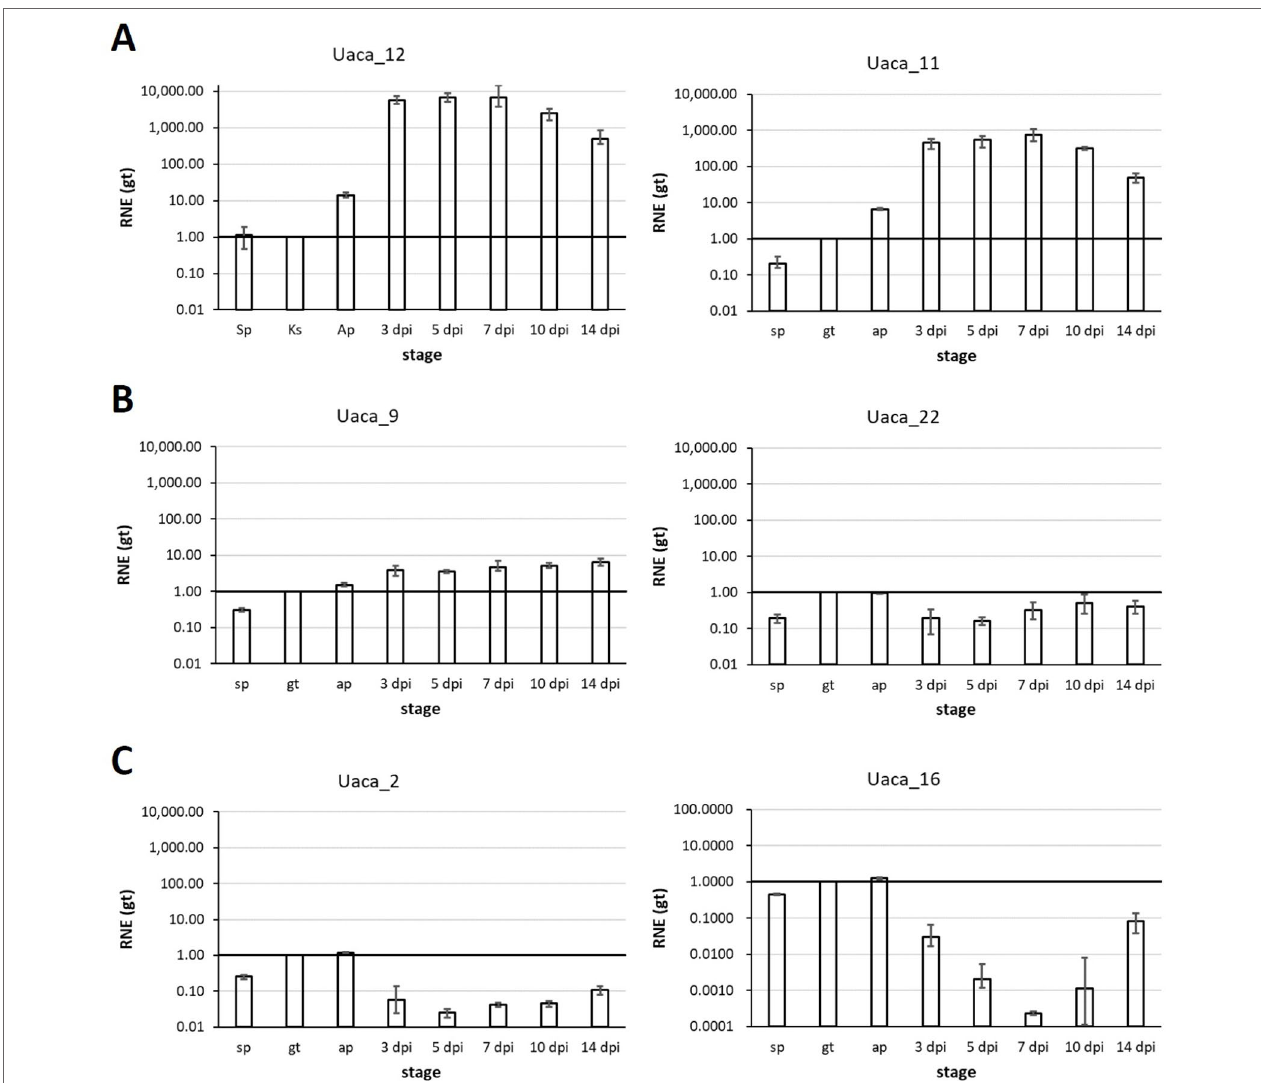
FIGURE 5 | Representative mRNA expression patterns of Uaca_Ns. Stages tested: in vitro : ungerminated urediospore (sp), germ tube (gt), appressorium (ap); in planta : 3, 5, 7, 10, and 14 days post inoculation (dpi). (A) Examples of Uaca_Ns that were strongly up-regulated in planta ; (B) examples of Uaca_Ns with little or no change in expression across the stages; (C) examples of Uaca_Ns that were down-regulated in planta . Columns show the geometric means of three biological replicates; error bars indicate maximum and minimum values. All values are relative to the gt stage; RNE, relative normalized